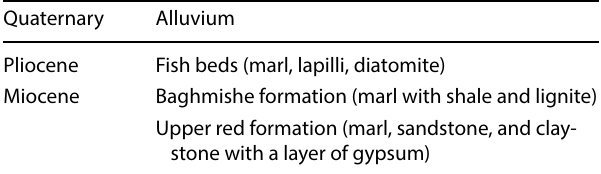
Table 1 Geological sequences and formations of Tabriz city